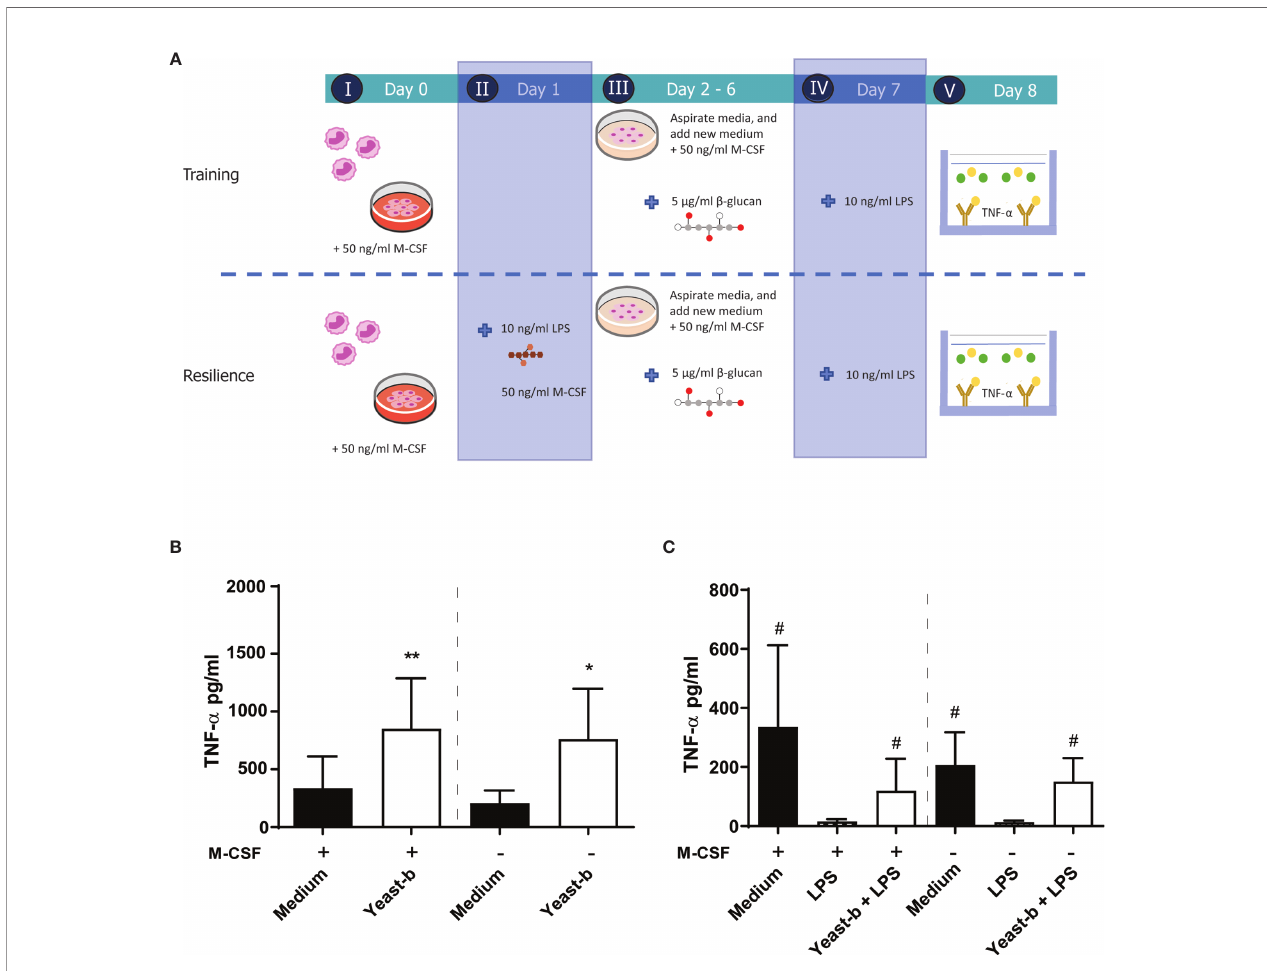
FIGURE 3 | Introducing new elements to the established training and resilience protocol to generate a macrophage model system. The protocol of in vitro training and induced resilience including the addition of M-CSF during step I-III and a prolonged incubation ( i.e. , day 2 to 6 instead of day 1) with b -glucan in the macrophage model is depicted in (A) Results from training (B) and induced resilience (C) in presence or absence of M-CSF and prolonged presence of b -glucan are shown in a bar graph as average pg/ml TNF- a ± SD of n =5 different donors. Data was analyzed with paired Student ’ s t test and statistical signi fi cances were indicated: *P < 0.05 compared to the medium control; **P < 0.01 compared to the medium control; # P < 0.05 compared to the LPS